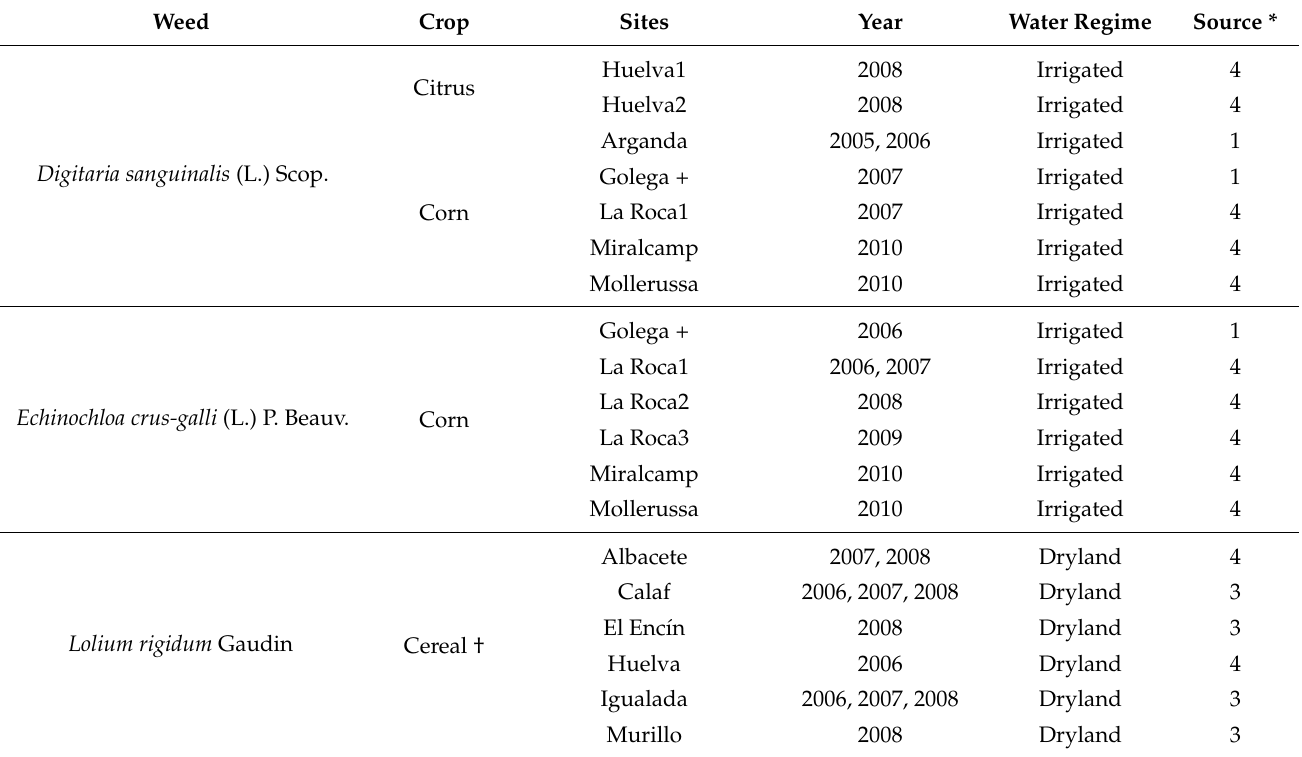
Table 1. Data sets used from Spain and Portugal ( + ) sites to test the differential form of the Gompertz function. More details are in the supplementary material